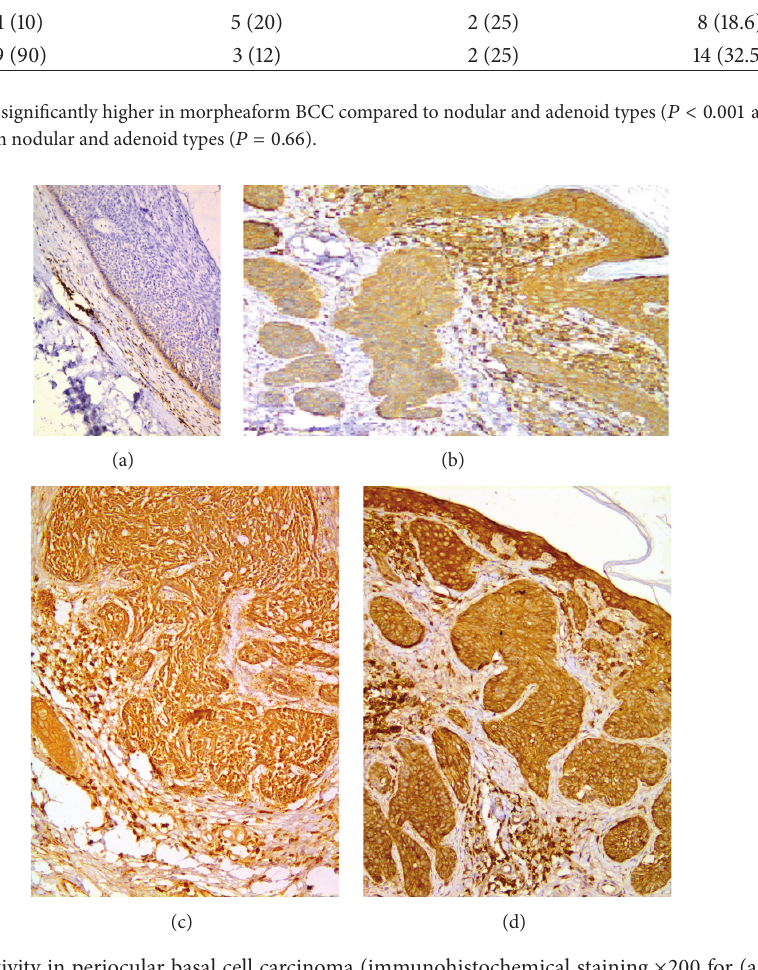
Figure 2: Ezrin immunoreactivity in periocular basal cell carcinoma (immunohistochemical staining × 200 for (a), × 100 for (b), × 200 for (c), and × 100 for (d)): (a) negative ezrin immunoreactivity, (b) weak ezrin immunoreactivity, (c) moderate ezrin immunoreactivity, and (d) strong ezrin immunoreactivity. Note strong immunoreactivity of tumor-associated lymphocytes and/or